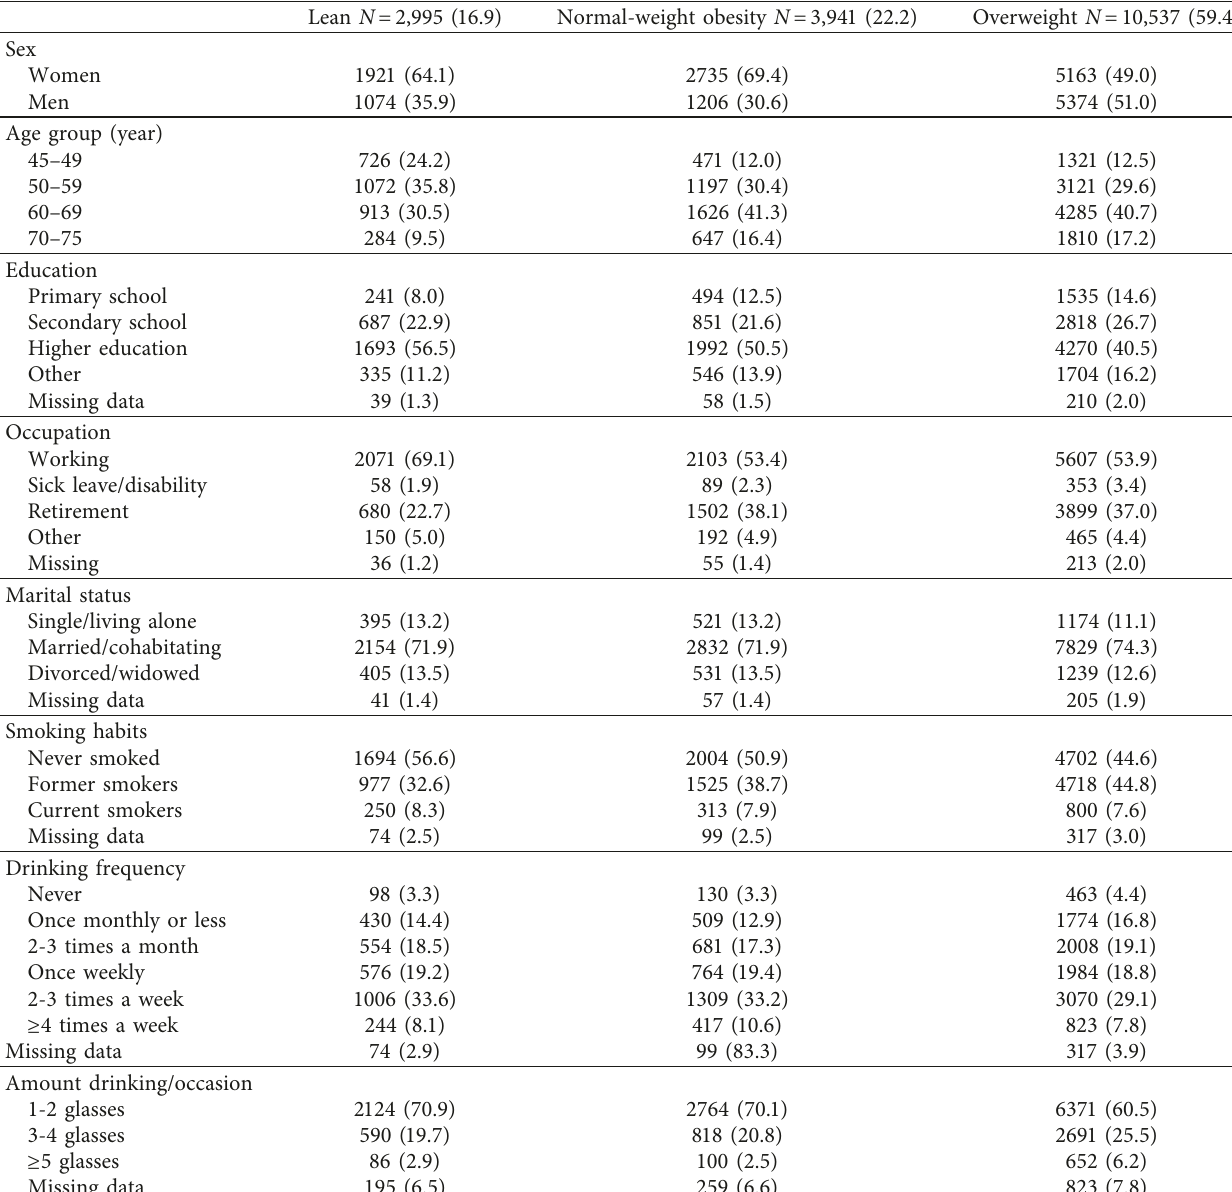
Table 2: Frequency of sociodemographic factors and smoking and alcohol habits in the EpiHealth cohort in relation to lean, normal-weight obesity, and